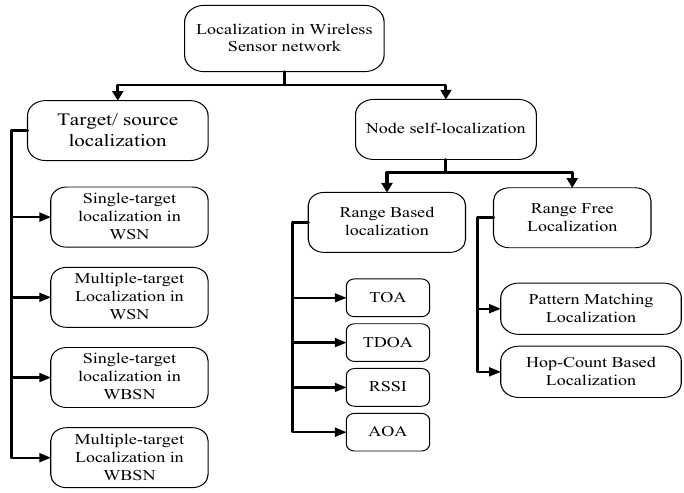
Figure 1. Classification of localization